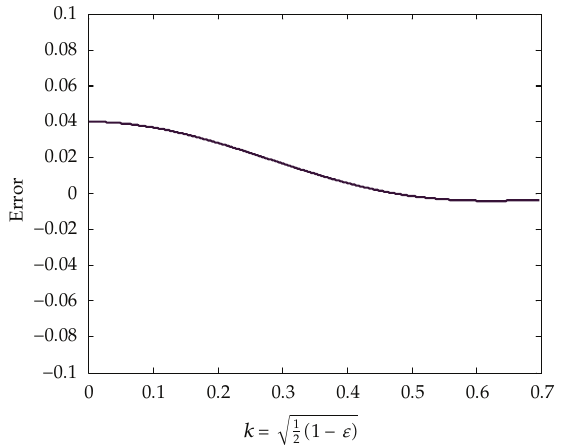
Figure 8: Relative error between the asymptotic solution and the numerical solution of the period as a function of the parameter k